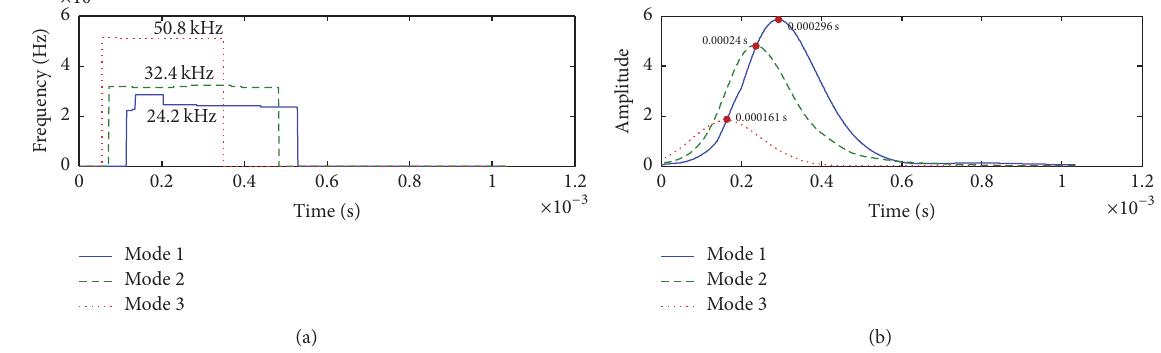
Figure 17: The final IFs and IAs of 30 mm defect by using the presented algorithm: (a) IF and (b) IA.